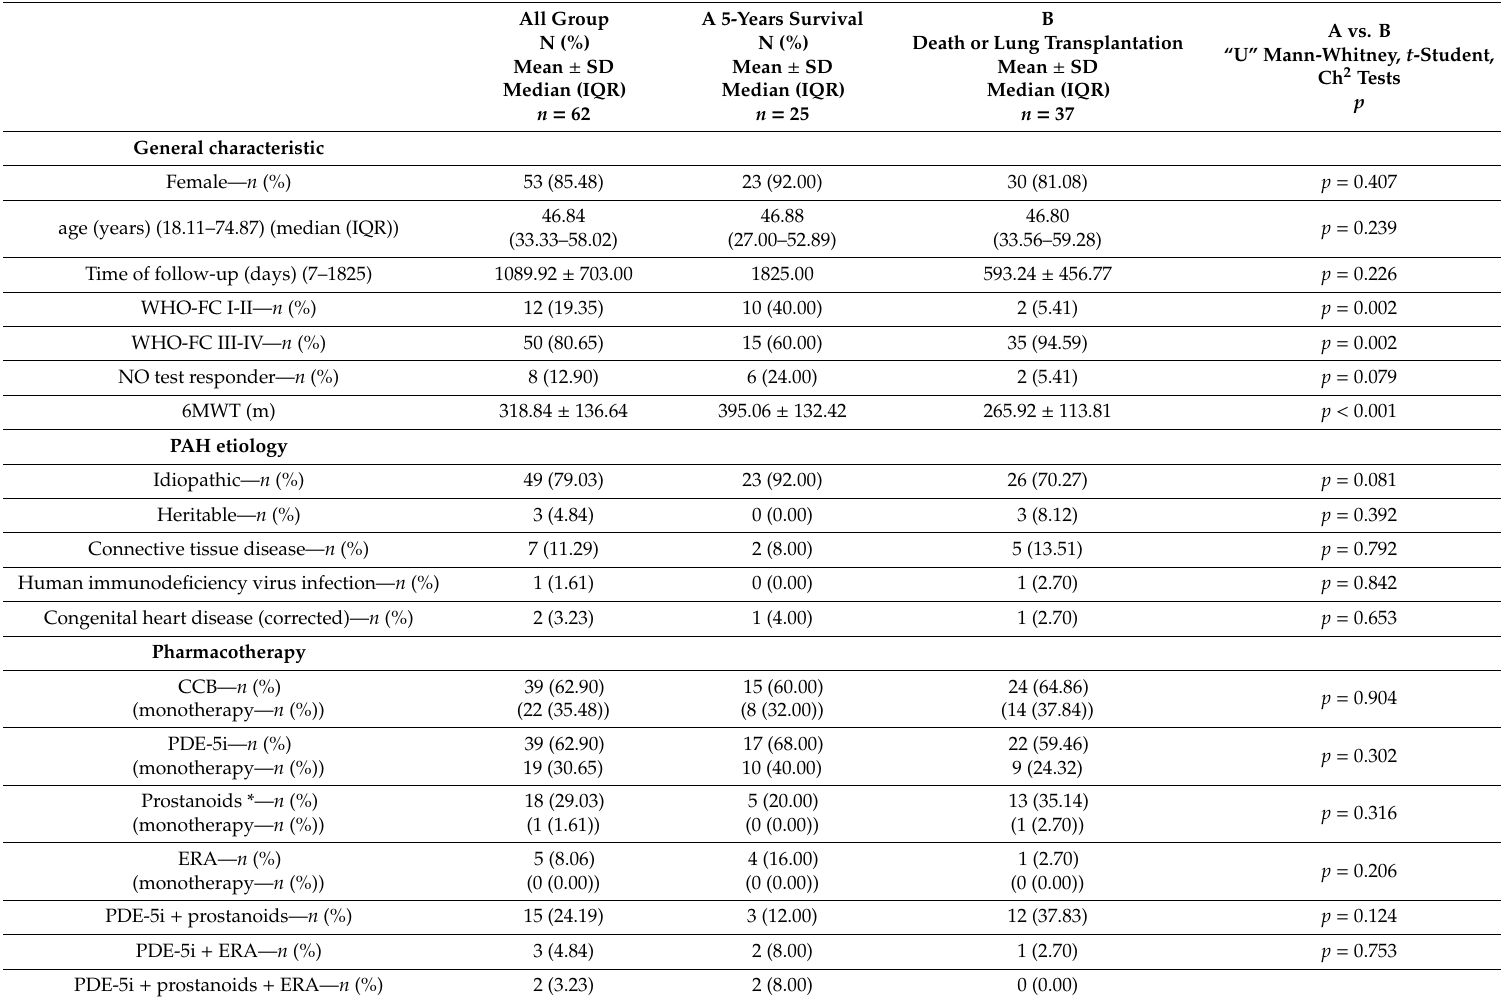
Table 1. Basic characteristic of examined clinical, laboratory and echocardiographic data in all group and subgroups separated depending on the prognosis in the five-year